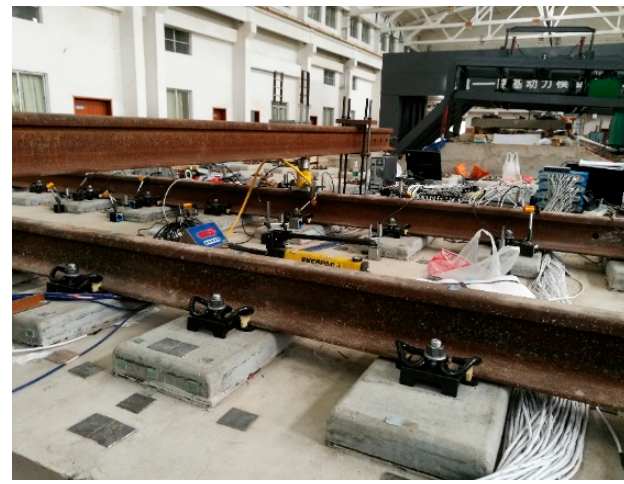
Appl. Sci. 2021 , 11 , x FOR PEER REVIEW Figure 11. Working condition one loading method. Figure 11. Working condition one loading method.